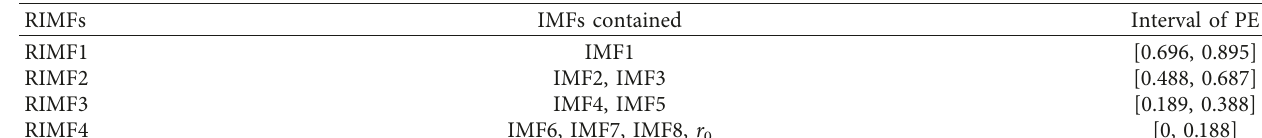
Table 4: Analysis of the reconstruction of IMFs.